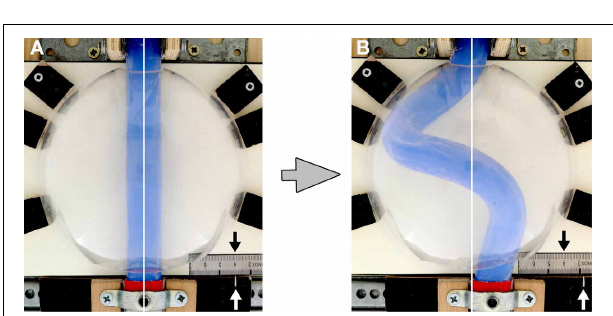
FIGURE 10 | These photographs taken at frontal views depict the leftward displacement of the “caudal” end of the silicone rod caused by left-handed helical buckling. (A) Straight rod before starting of the buckling test. Note the midline position of the center axis of the silicone rod. (B) Silicone rod during helical buckling. Note the leftward displacement of the “caudal” end of the